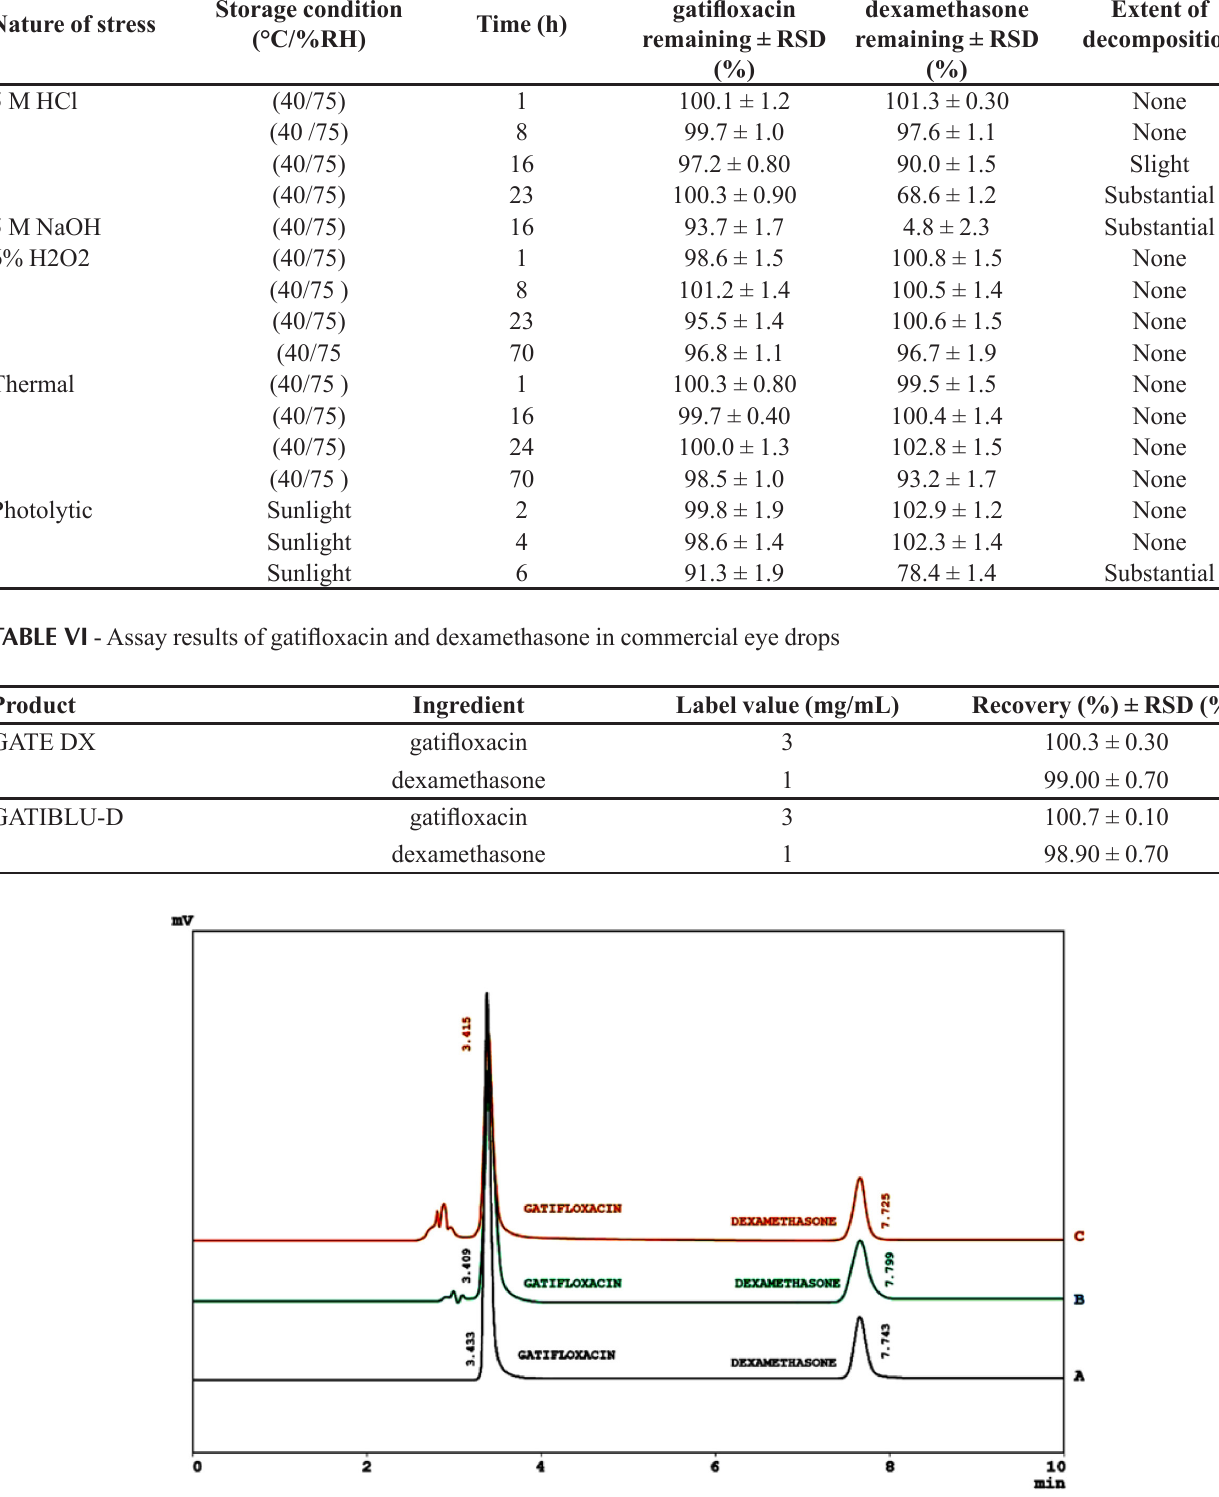
FIGURE 3 - Chromatograms of gatifloxacin and dexamethasone in Pharmaceutical Formulations (A), Human Serum (B) and Urine